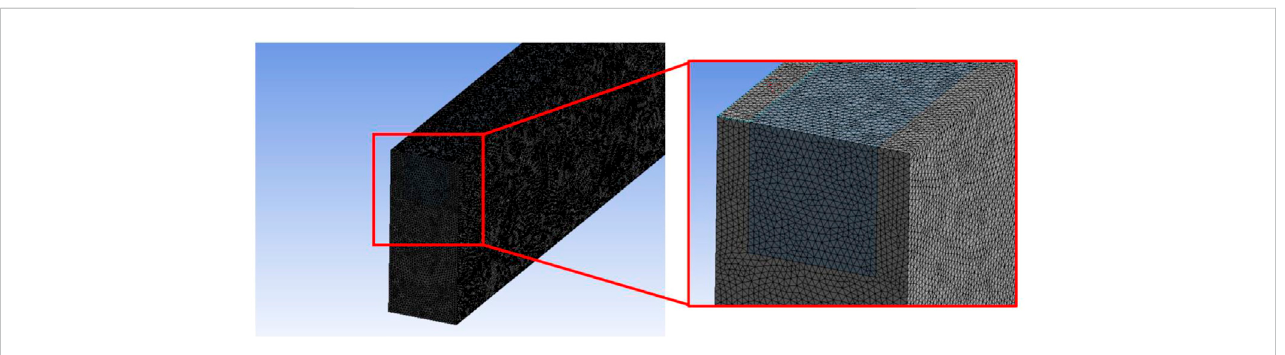
FIGURE 3 The schematic diagram of 0.1 mm